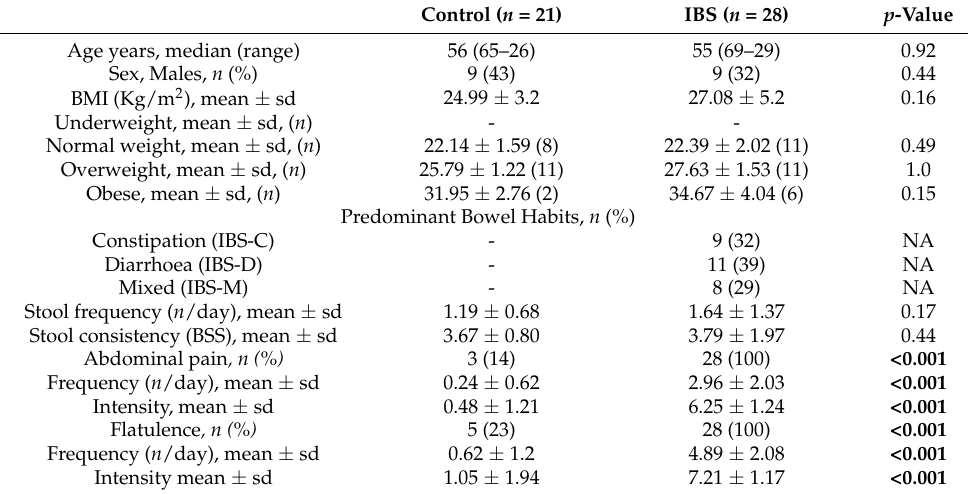
Table 1. Subject